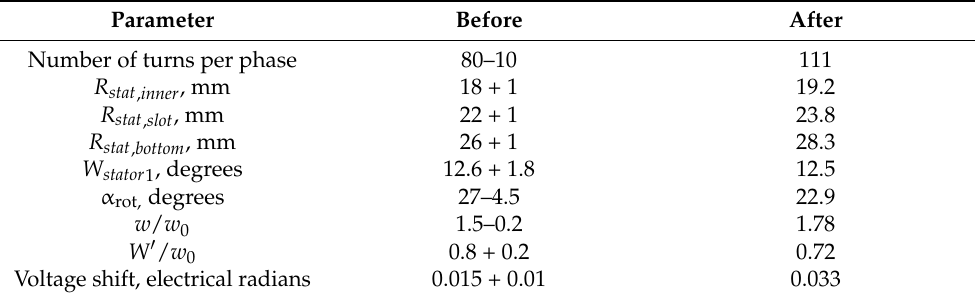
Table 2. Parameters that changed during the optimization.